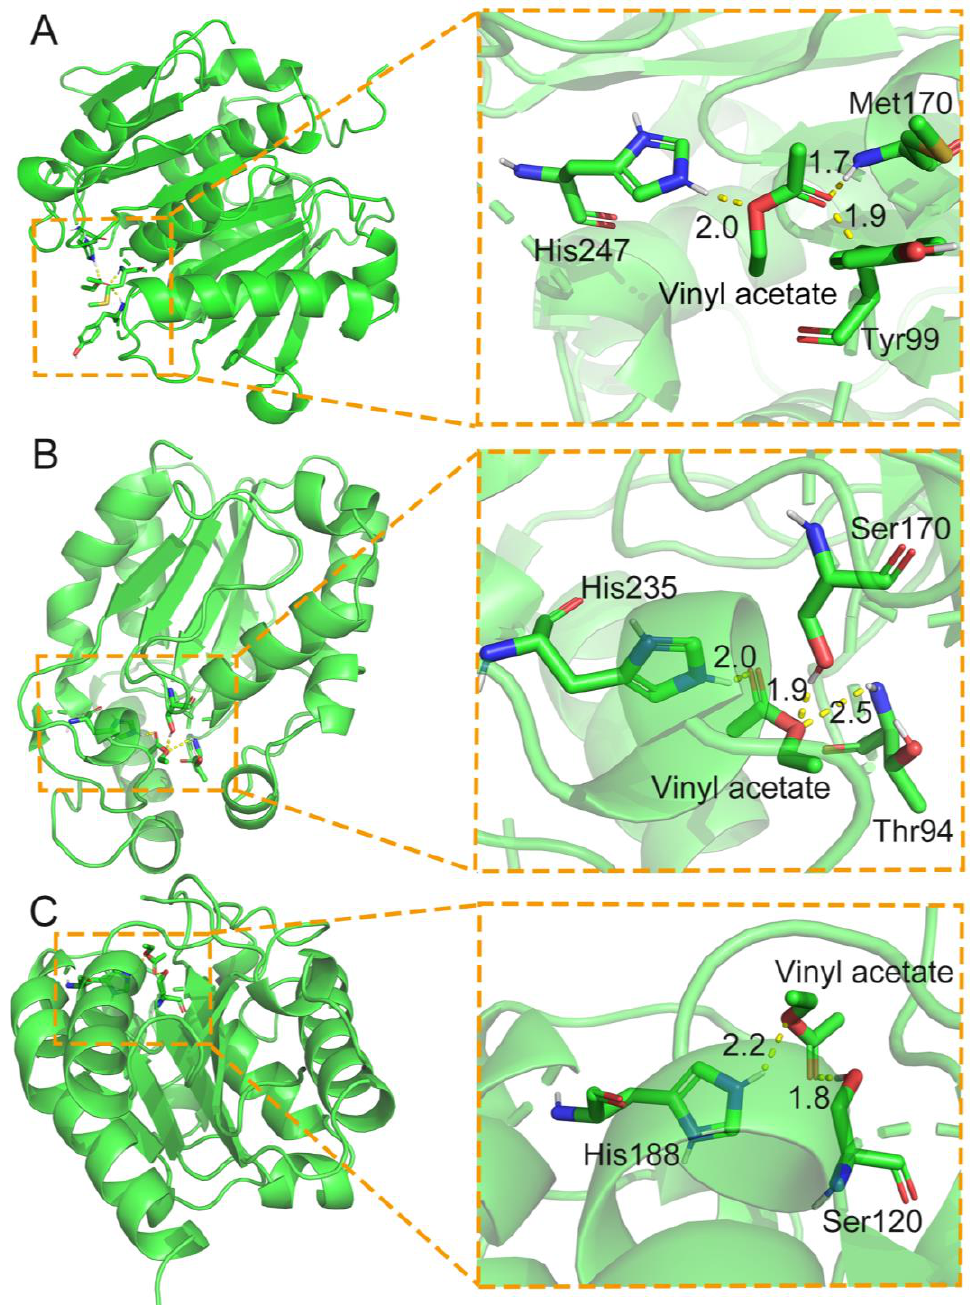
Figure 5. Autodock analysis of representative cutinases, which can form acyl-enzyme intermediates with the acyl donor of vinyl acetate. ( A ) Docking of vinyl acetate in the structure of cutinase (PDB: 6AID). ( B ) The primary sequence of one Aspergillus oryzae cutinase (NCBI: OOO09588.1) was modelled in its structure by SWISS-Model [68,69] before docking analysis with vinyl acetate. ( C ) Docking of vinyl acetate in the structure of cutinase (PDB: 1FFB).